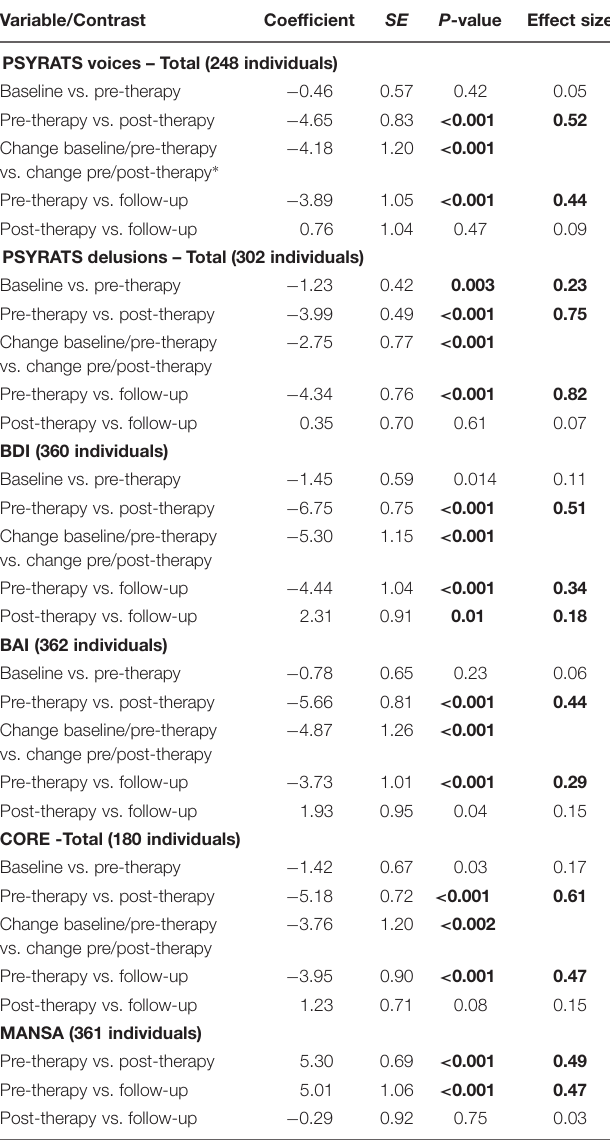
TABLE 1 | Mixed Effects Regression Results for the Effectiveness of